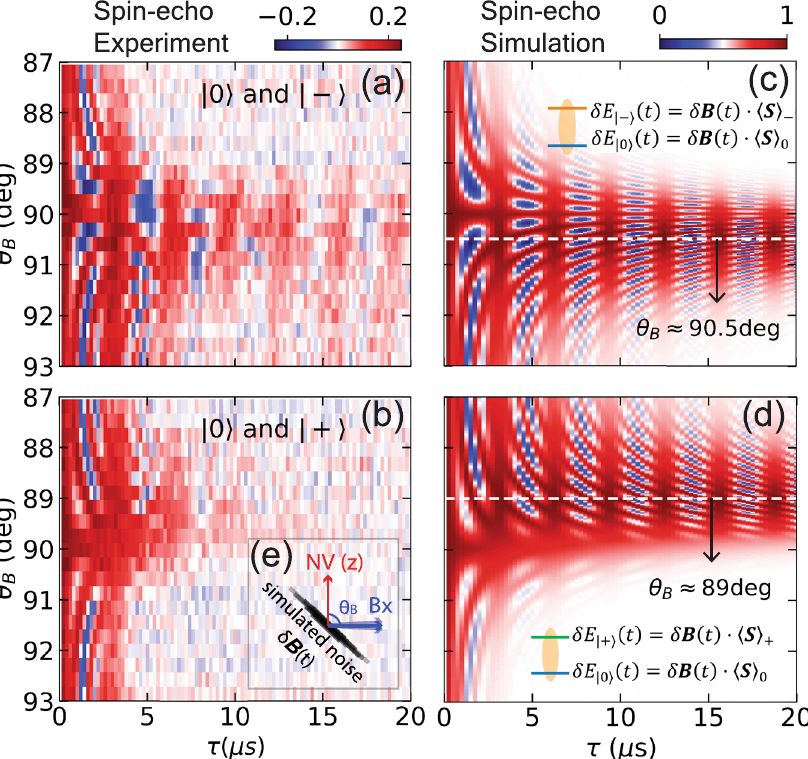
Fig. 4 Asymmetric angle dependence of the NV coherence time. a , b Spin-echo experiments between 0 j i and ∓ j i as θ B varies under ∣ B ∣ ≈ 93 G. Colorbar represents the fl uorescence contrast. The asymmetry between θ B < 90° and θ B > 90° originates from local anisotropic magnetic fi eld noise in the sample. c , d Simulated spin-echo signals with a magnetic fi eld noise acting along a direction at − 45°/ + 135° from the þ ^ x axis, as depicted in ( e ). The white dashed lines mark the optimal angles at which the noise coupling is maximally suppressed. Colorbar represents the spin-echo